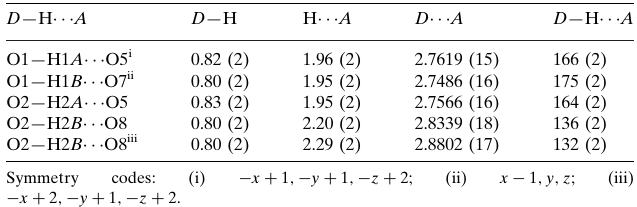
Hydrogen-bond geometry (A˚ , (cid:3)